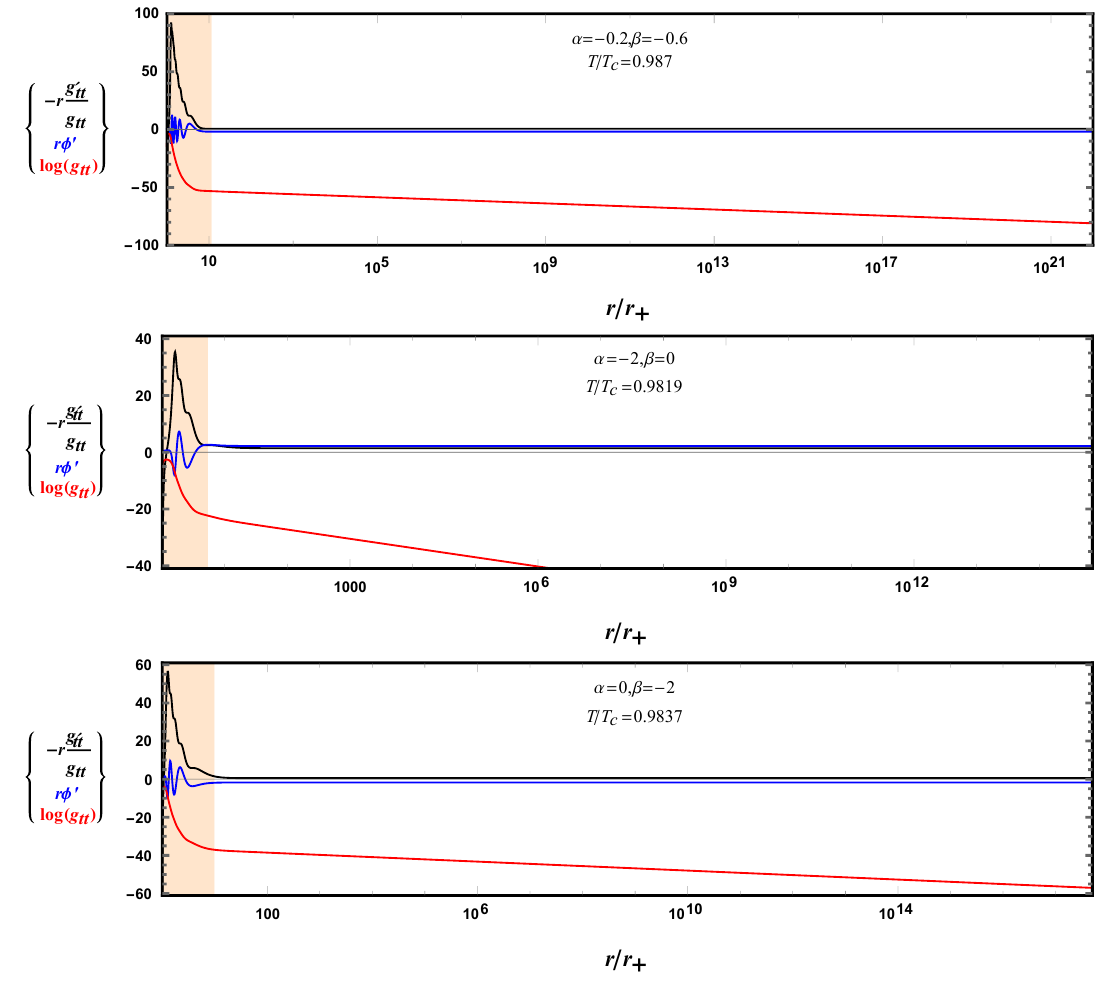
Figure 10 . Typical examples of the interior evolution with no Kasner inversion in different config- urations of the massive gravity. In 1 < r < 10 (orange shaded area) the system experiences the ER bridge collapse and Josephson oscillations epoch, then it stays in Kasner regime for ever. Clearly, in all panels, the function log( g tt ) begins to collapse, while the other functions rφ 0 and − rg 0 become constants in the Kasner epoch. In all these graphs κ/µ = 1